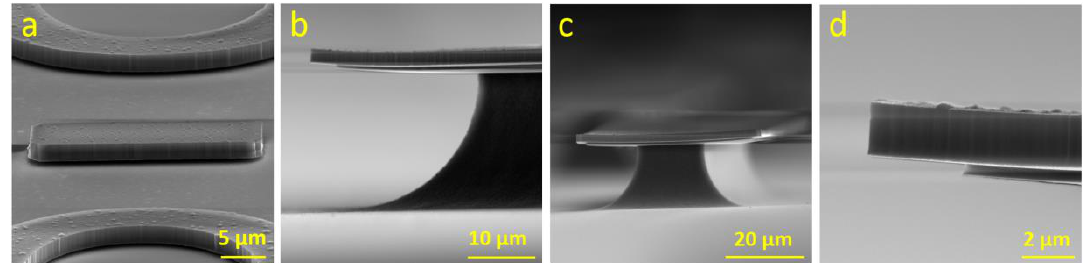
Figure 3. SiO 2 etched with HF/oleum, showing the undercutting with Al layer intact: ( a ) Structures undercut by SiO2 etch solution leaving intact Al. ( b ) The same etching of SiO 2 followed by partial Si removal by XeF 2 vapor to enhance visibility of SiO 2 etch boundary. ( c ) Different angle and magnification show whole structure ( d ) and corner detail.